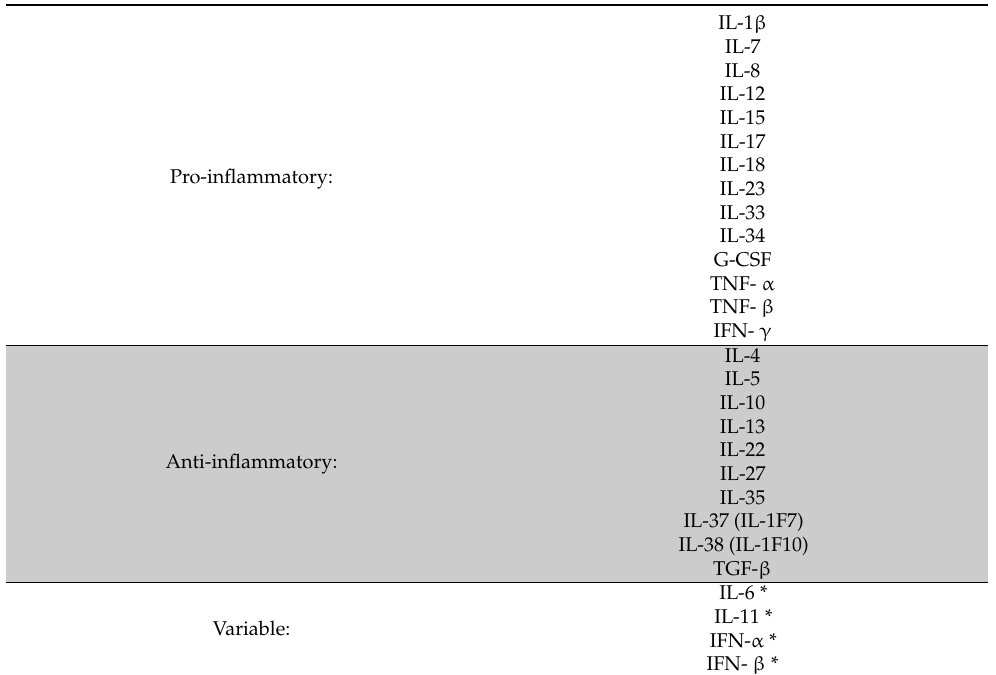
Table 2. Cytokine family divided into functional families based of inflammatory nature of